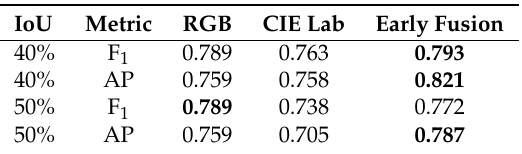
Table 6. F 1 scores of RGB , CIELab and Early Fusion at AP40 and 50 on the DeepFruit data set (0.799 at AP40). Bold indicates the best result in each row.